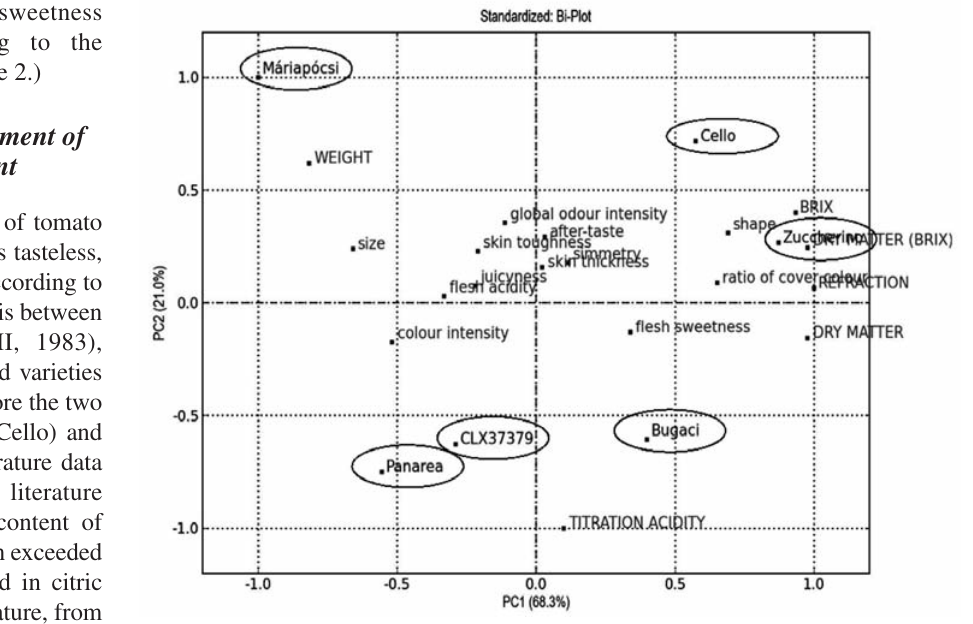
separation from stem shape size colour intensity ratio of cover colour juicyness